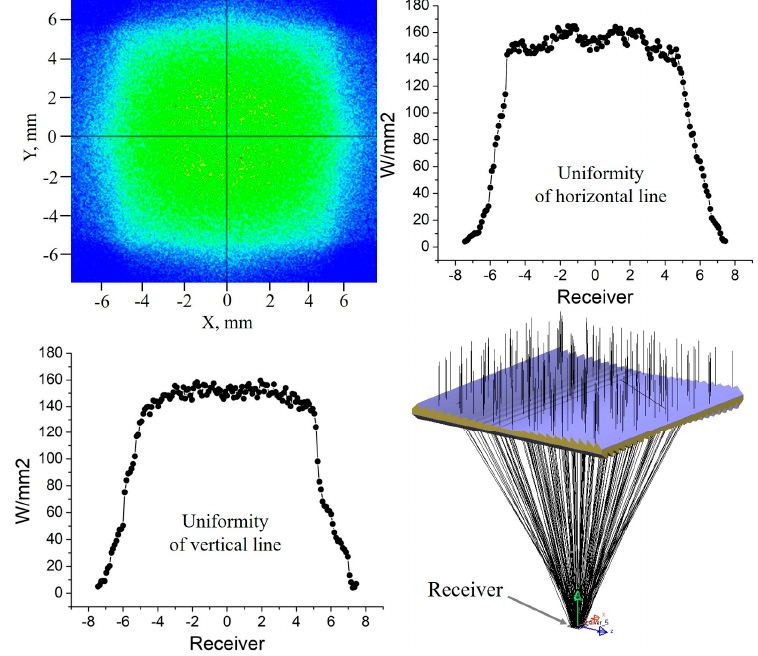
Figure 14. Ray tracing of the novel designed lens, irradiance distribution of the sunlight over the receiver, and the uniformity on the horizontal and vertical investigation lines.